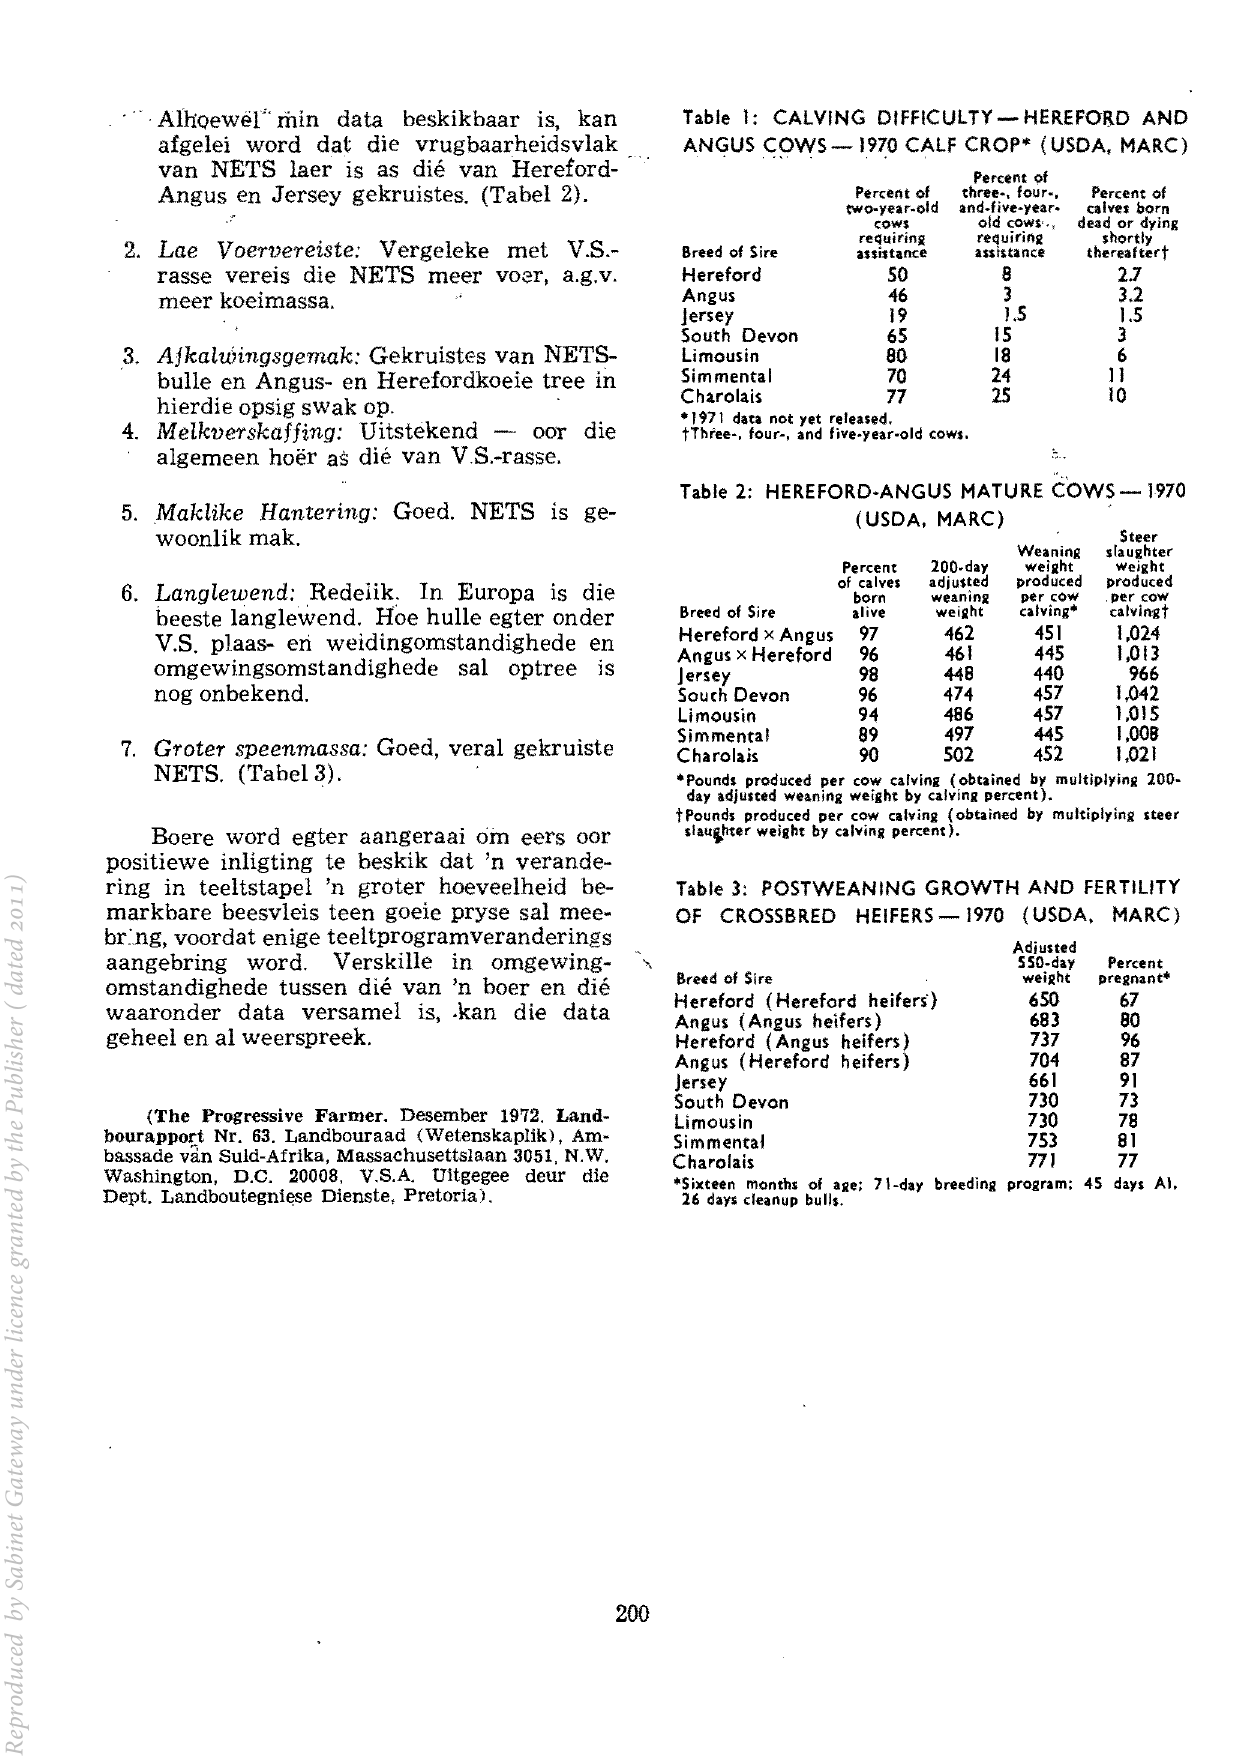
Table 1: CALVING DIFFICULTY-HEREFORD AND ANGUS C()WS-1970 CALF CROP" (USDA, MARC) Percent of Percent of three .. , four .. , Percent of two-year.old and-five-year.